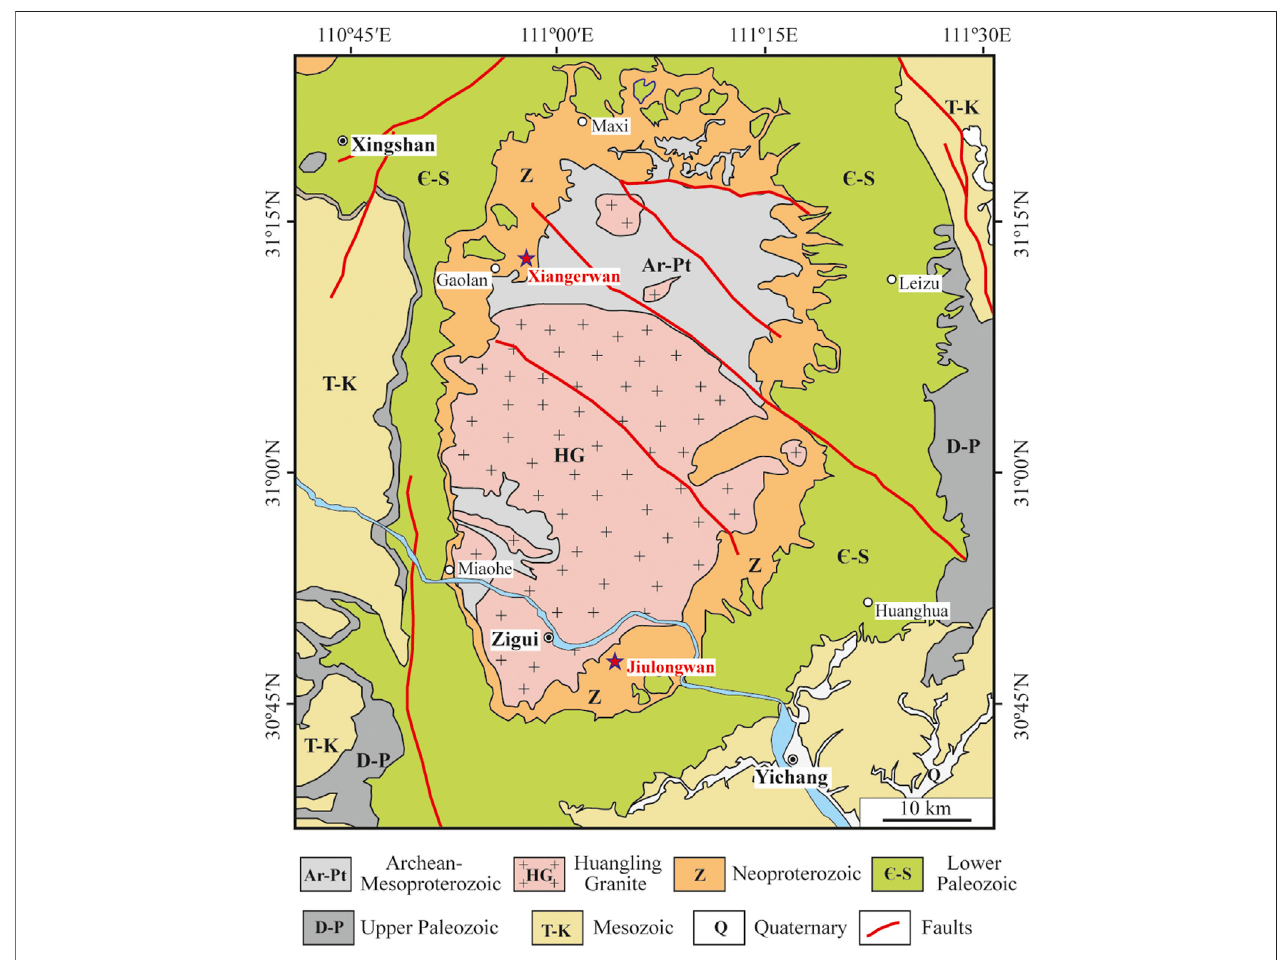
FIGURE 1 | Simpli fi ed geological map in the Yangtze Gorges area (modi fi ed from An et al., 2015). Red stars show the locations of two study sections.